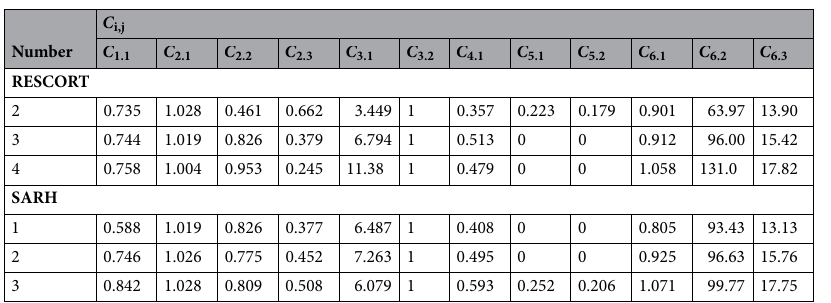
Table 9. Value of decomposition effect level indicators C 1.1 ∼ C 6.3